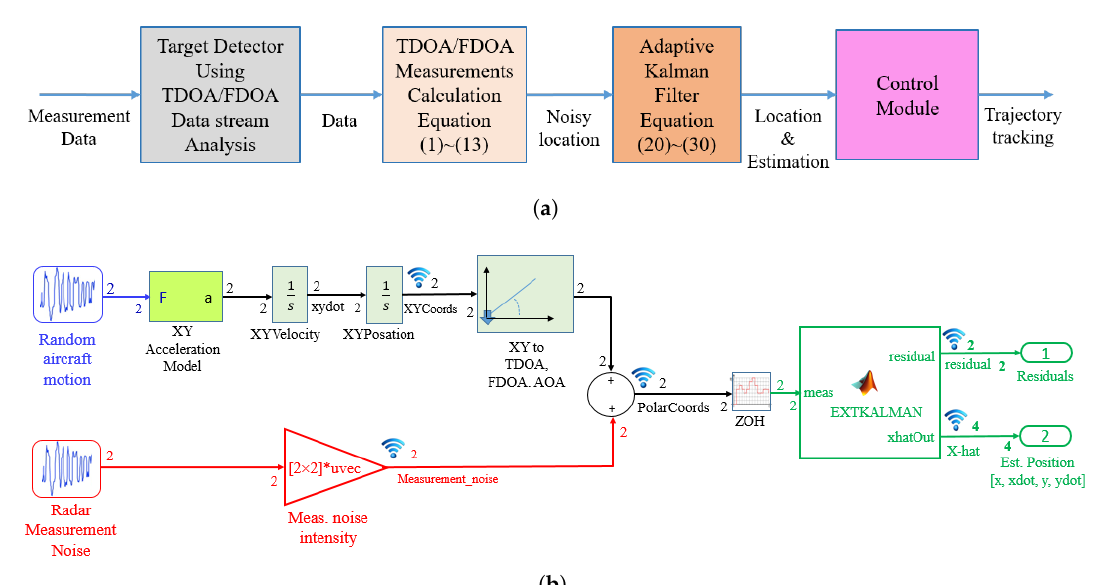
Figure 21. Structure and Simulink of algorithms for target tracking estimation (modified into Adaptive Extended Kalman Filter with TDAO/FDOA/AOA measurement). ( a , b ) show the framework of localization and target tracking using A EKF based on TDOA/FDOA measurements and Radar tracking using MatLab Function Block respectively. ( a ) [112], ( b )